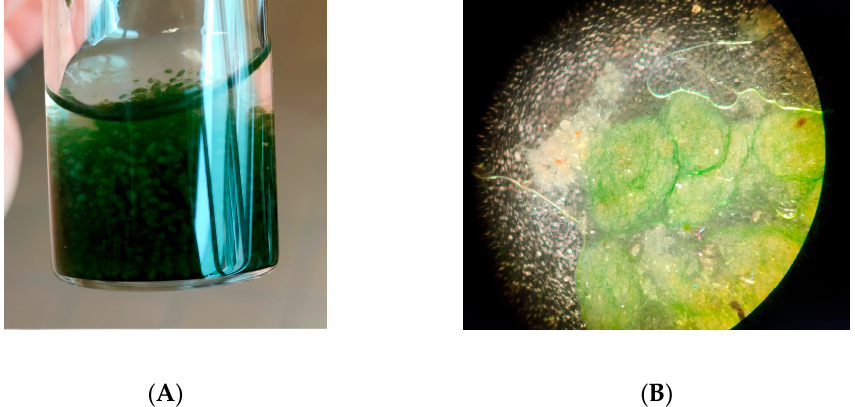
Figure 2. OPGs formed during hydrodynamic cultivation: ( A ) in a vial, ( B ) an image obtained from a stereomicroscope (own study).